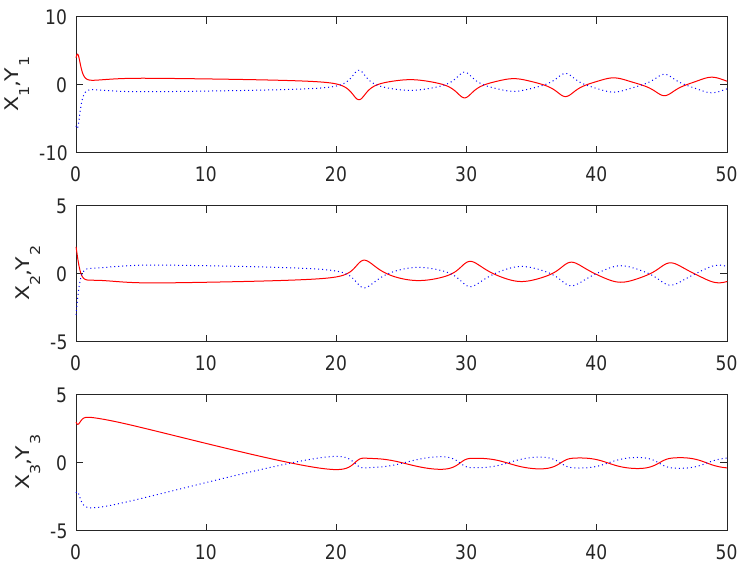
Figure 10. The states of the master subsystem and the slave